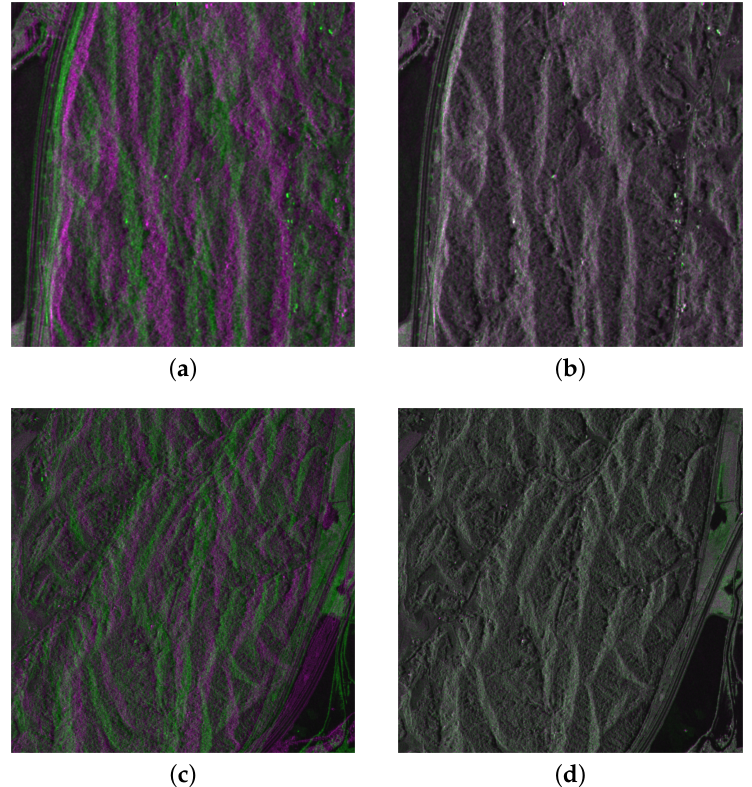
Figure 5. The fusion image of ( a ) the original GF0719 (in green) and original GF0731 (in purple); ( b ) the original GF0719 (in green) and the epipolar resampled GF0731 (in purple); ( c ) the original GF0721 (in green) and original GF0709 (in purple); ( d ) the original GF0721 (in green) and the epipolar resampled GF0709 (in purple).